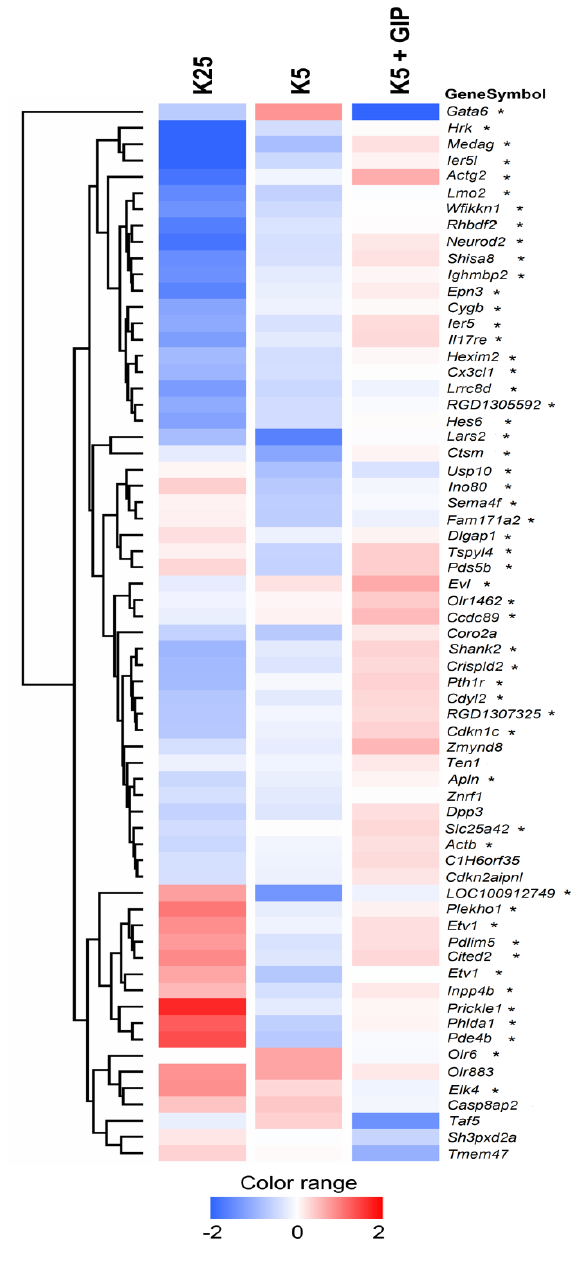
Figure 1. Hierarchical clustering of genes differently expressed in CGNs treated with Gip, during the pre-commitment of apoptosis. Sixty-five rescue genes (differentially expressed in K5 vs. K5 + Gip); were named using their UniGene symbol and were ordered into a dendrogram, whose length of the branches represents the relatedness of the expression levels in different experimental conditions. Data are presented in a matrix format: each row is equivalent to a single gene and each column is equivalent to one of the three different experimental conditions (K25, K5, K5 + Gip). The color of the corresponding cell in the matrix indicates the averaged normalized intensity from replicates. Red, blue and white respectively represent transcript levels below, equal or above the median abundance across all conditions. Color intensity reflects the magnitude of the deviation from the median (see scale below). Rescue genes differently expressed also following induction of apoptosis (K25 vs. K5) are indicated by *